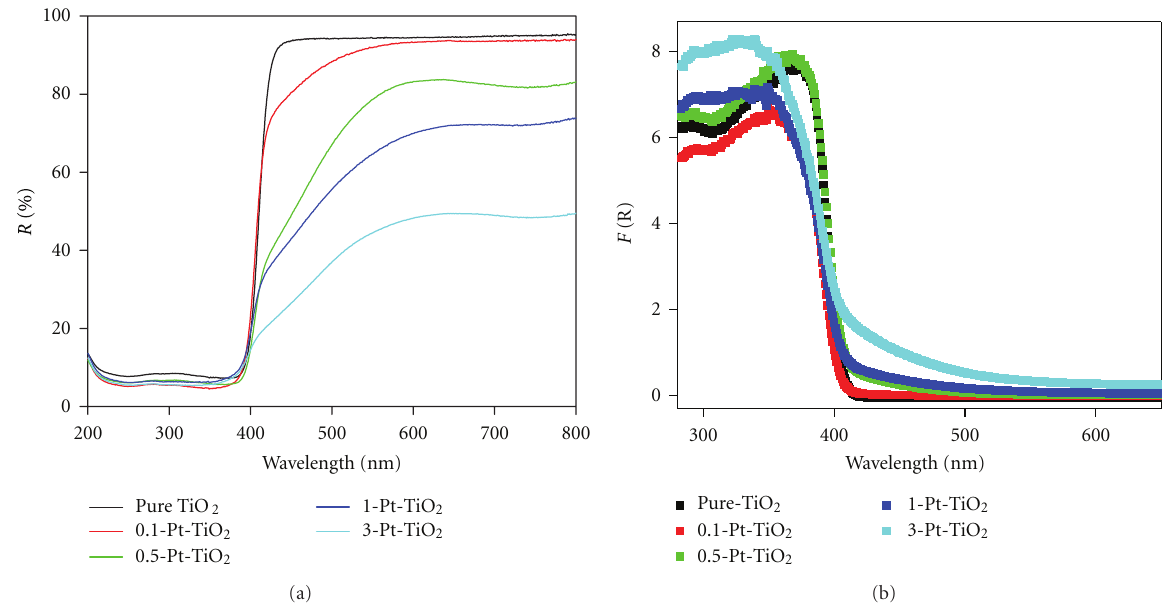
Figure 3: UV-visible di ff usion reflectance spectra of TiO 2 microspheres with Pt